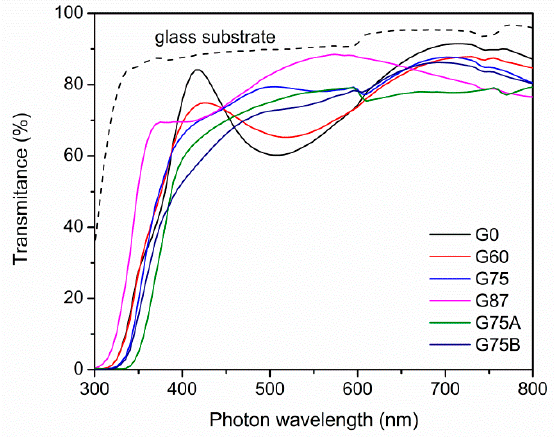
Figure 3. UV-visible optical transmission spectra of the TiO 2 films on glass substrate.